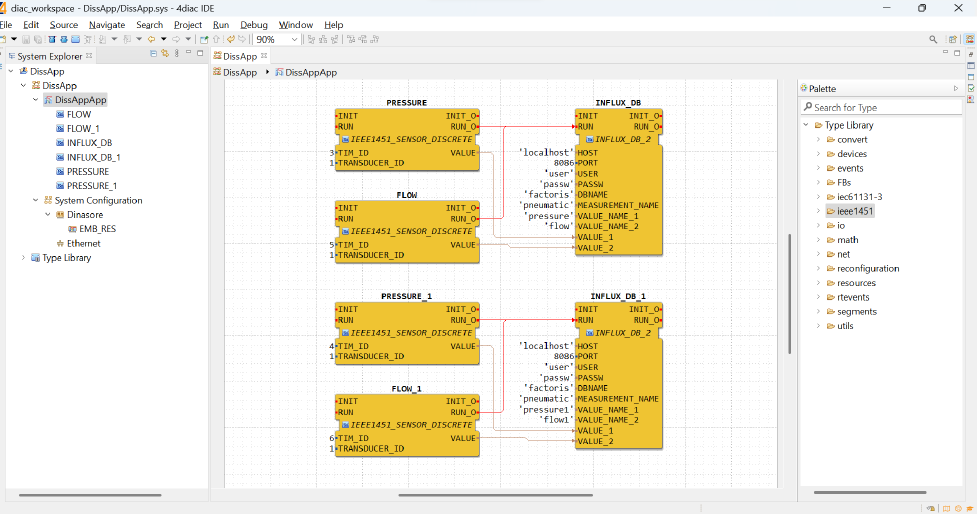
Figure 8. 4diac IDE application—Test